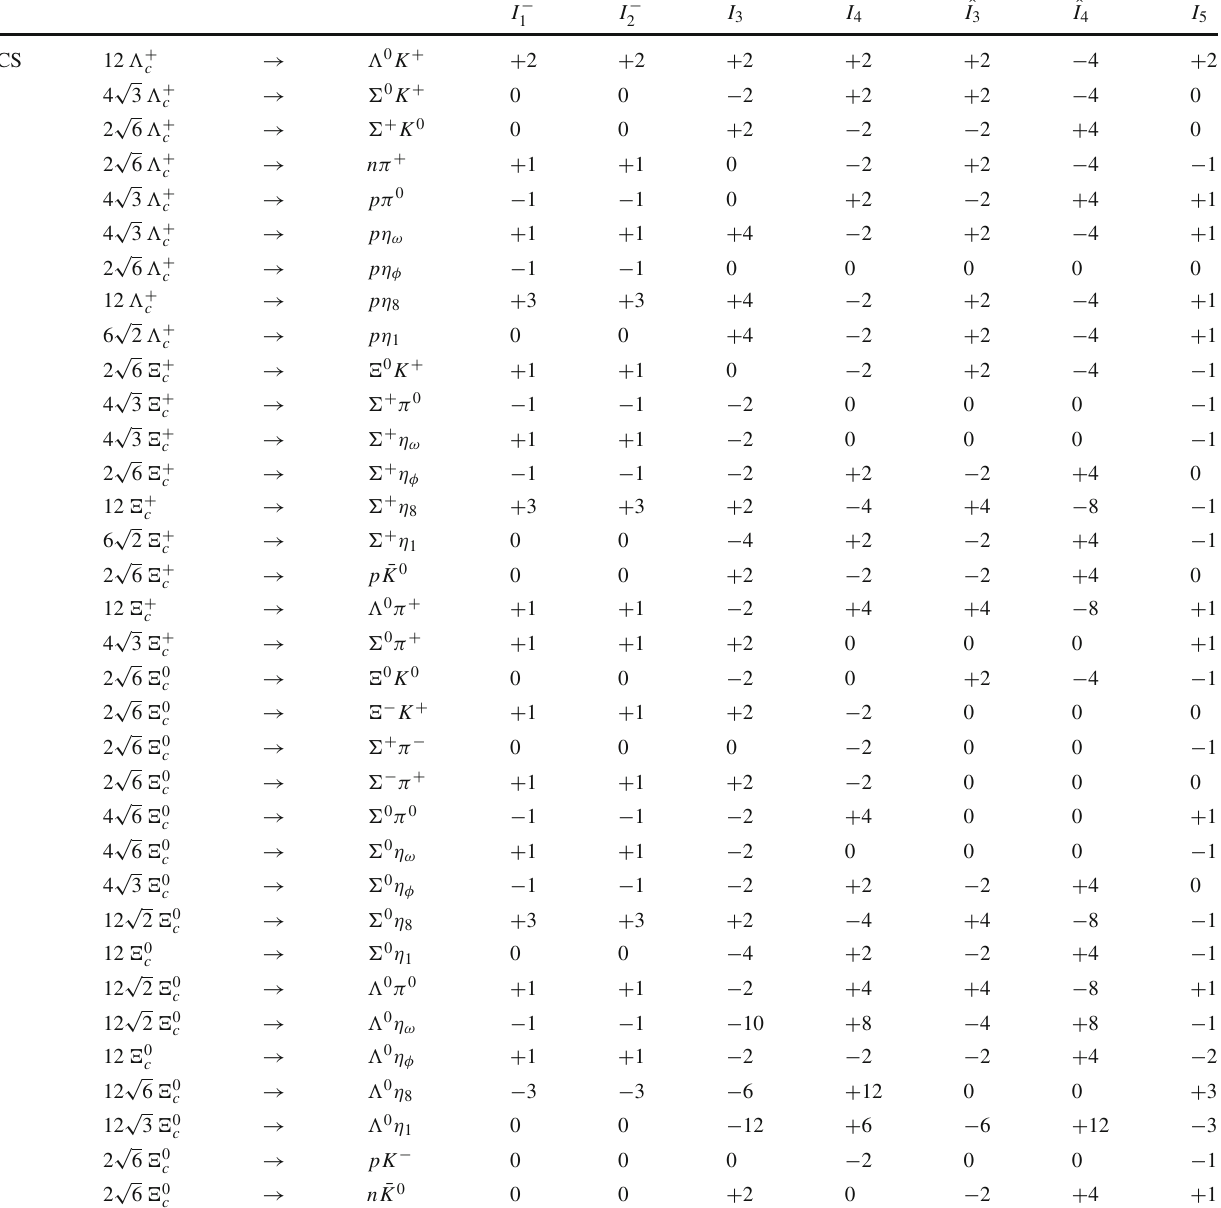
Table 6 Values of the seven topological tensor invariants for the SCS antitriplet charm baryon decays B c ( 3 ) → B ( 8 ) + M ( 8 , 1 ) induced by both flavor transitions (a) and